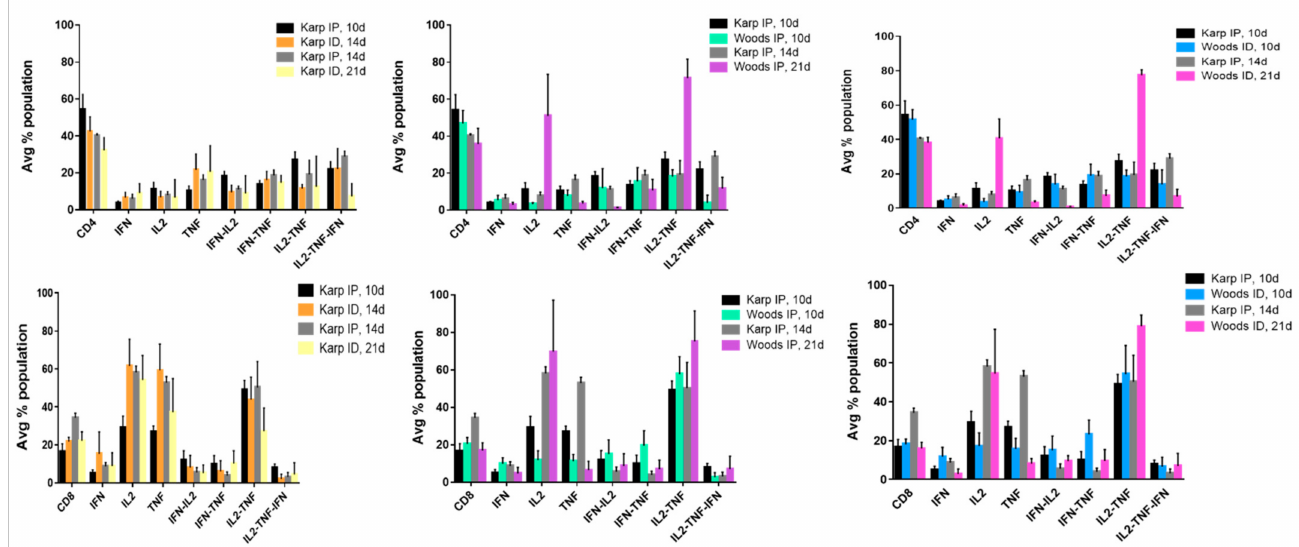
Figure 6. Multifunctional cytokine analysis of O. tsutsugamushi -specific CD4+ or CD8+ T cells represented by the frequency of cytokine (single, double, or triple) positive cells. Inter- and intrastrain comparisons are shown for the lethal (Karp IP) and nonlethal (Karp ID, Woods IP, and Woods ID) models of murine O. tsutsugamushi infection. The intracellular cytokine profiles for IFN γ , IL2, and TNF α in individual cells were measured by multicolor flow cytometry with gating for CD4+ or CD8+ T cells. All possible combinations of cytokines are shown on the x -axis; the frequency of each population is shown as the mean ± SD on the y -axis.